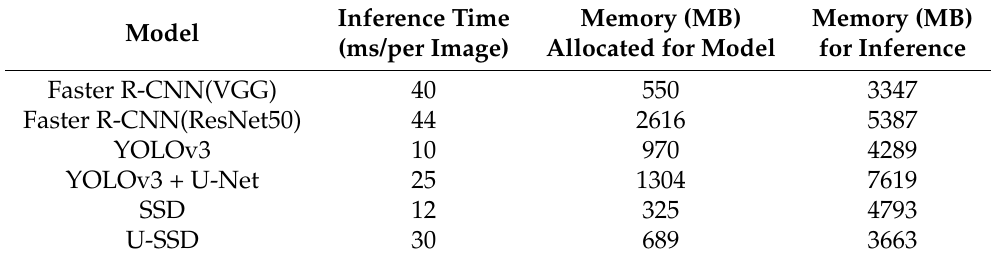
Table 7. The performance of inference and the usage of GPU memory under IoU = 0.5 on our